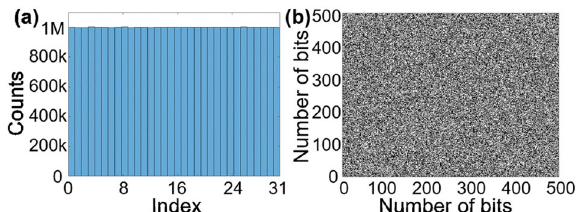
Figure 4. Representation of a 160 Mb bit stream. ( a ) Histogram displaying the distribution amongst the 5 LSBs. ( b ) Bit map with the first 500 × 500 random bits shown in a 2D array, where bits “0” are converted to black and bits “1” are converted to white.